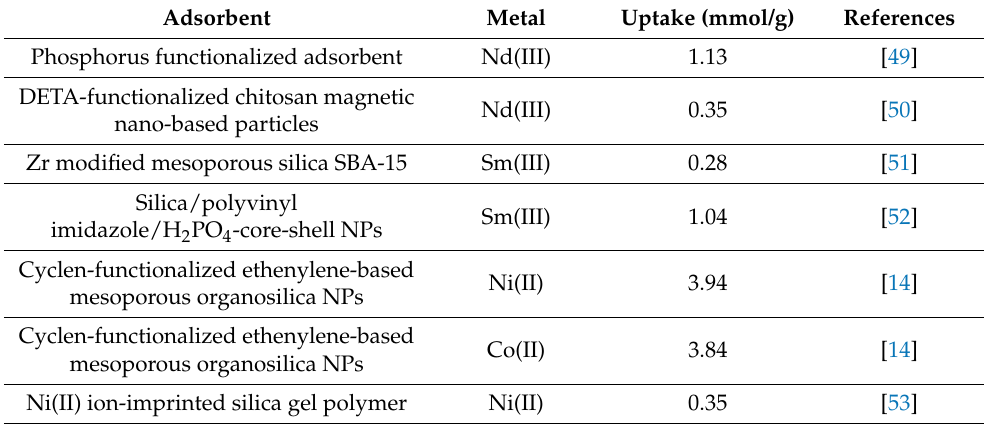
Table 3. Maximum adsorption capacities of different adsorbents towards REEs and LTM.